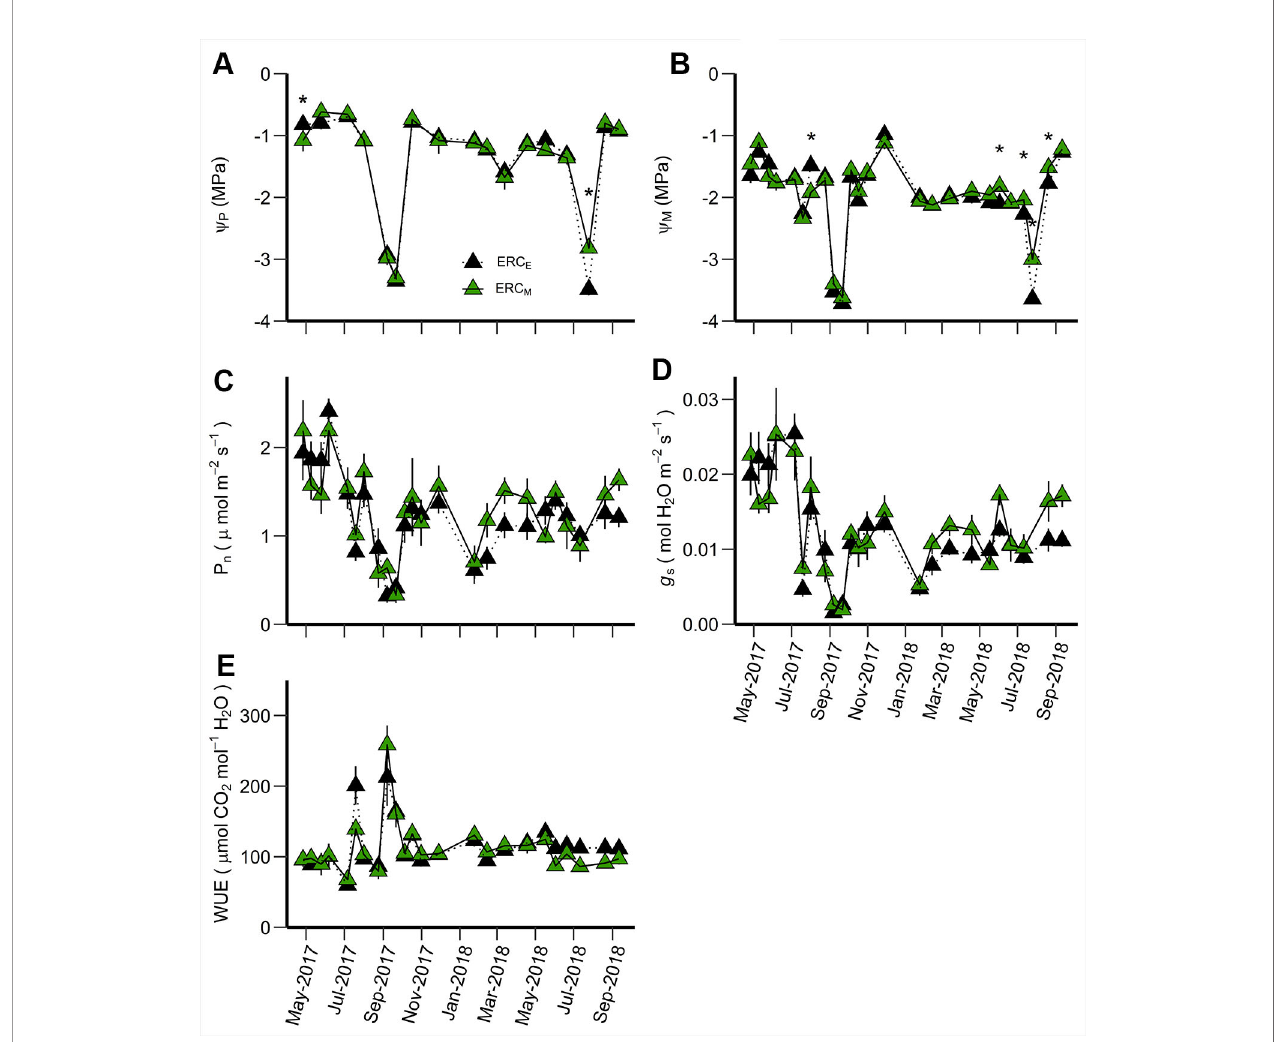
FIGURE 4 | Predawn water potential ( Y P ) (A) , midday water potential ( Y M ) (B) , net photosynthetic rate (P n ) (C) , stomatal conductance (g s ) (D) , and water use ef fi ciency (WUE) (E) for ERC M vs. ERC E . ERC M are eastern redcedar trees growing in a mixed-species stand while ERC E are eastern redcedar trees growing in single-species stands. An asterisk (*) indicates signi fi cant differences on speci fi c dates (p < 0.05). Vertical bars represent standard errors of measurements at each date (not shown when smaller than the symbol